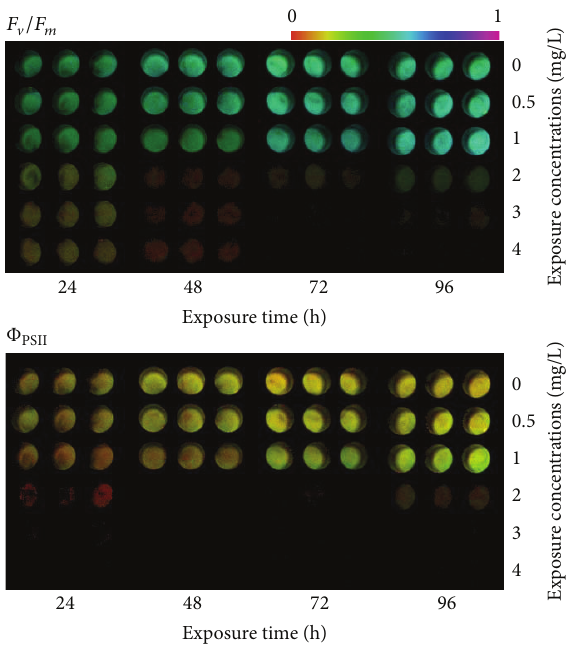
Figure 4: The fluorescent imaging of C. vulgaris under the stress of ethyl